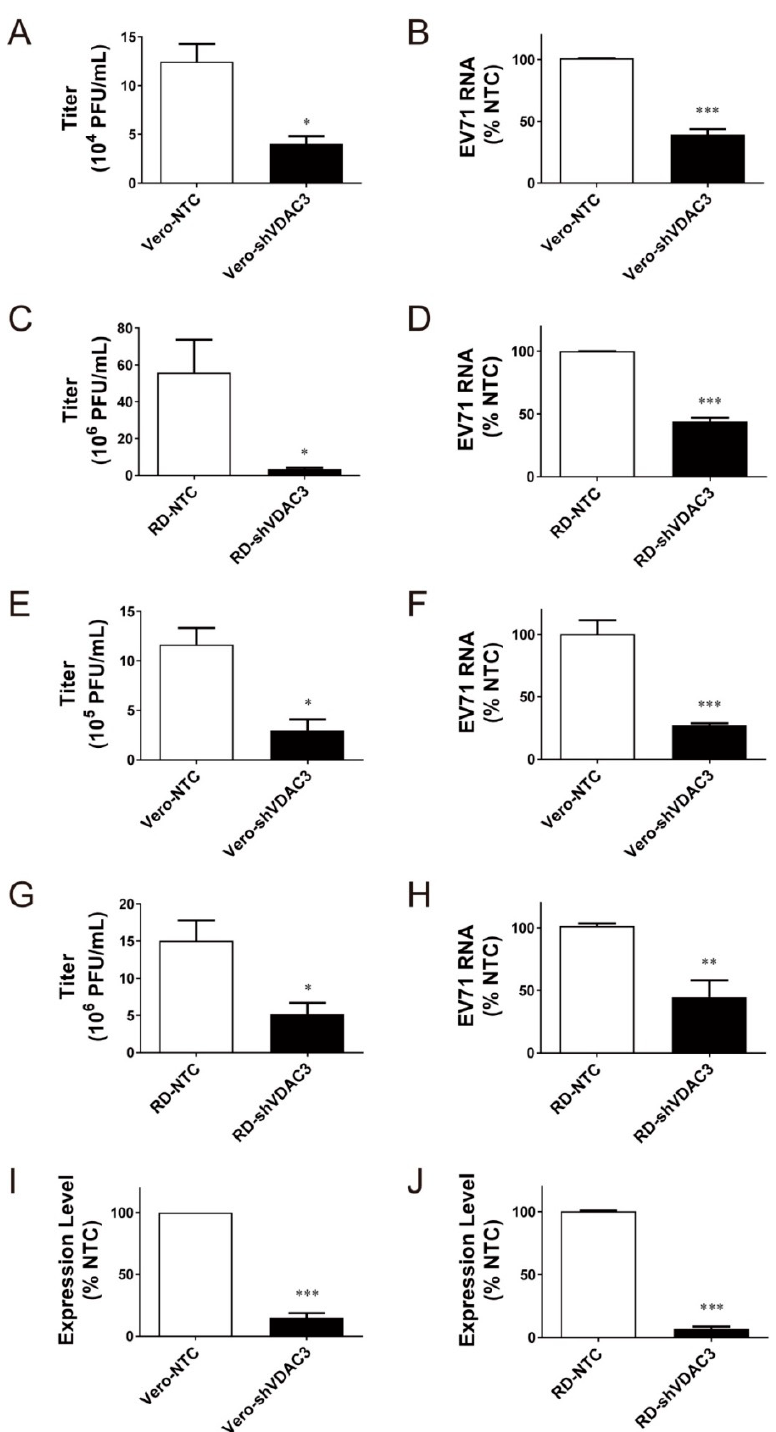
Figure 5. VDAC3 plays an essential role in viral replication. Vero and RD cells were transduced with the lentiviral vectors encoding control shRNA ( NTC ), or the shRNA against VDAC3 ( shVDAC3 ), to generate Vero ‐ NTC, Vero ‐ shVDAC3, RD ‐ NTC, and RD ‐ shVDAC3 cells, respective ‐ ly. ( A – D ) Vero ‐ shVDAC3 and Vero ‐ NTC cells were infected with EV71 at an MOI of 1.25 for 1 h ( A , B ), while RD ‐ shVDAC3 and RD ‐ NTC cells were infected at MOI of 0.01 ( C , D ). Twenty ‐ four hours later, the titer ( A , C ) and genomic RNA level ( B , D ) of the progeny virus were determined. (E ‐ H) Vero ‐ shVDAC3 and Vero ‐ NTC cells were infected with EV71 at an MOI of 10 for 1 h ( E , F ). RD ‐ shVDAC3 and RD ‐ NTC cells were similarly infected ( G , H ). Six hours later, the titer ( E , G ) and